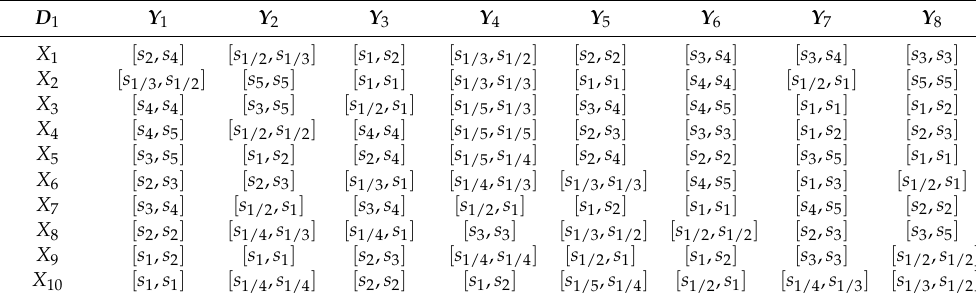
Table 4. The normalized evaluation information matrix of D 1 .